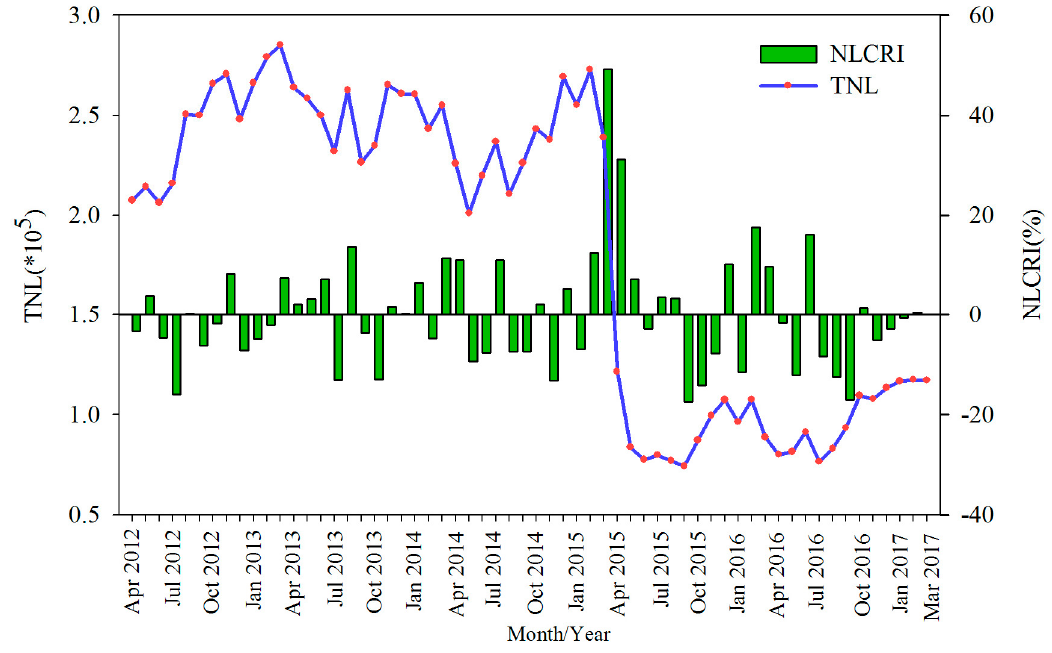
Figure 8. TNL of Yemen from April 2012 to March 2017 at a national scale.